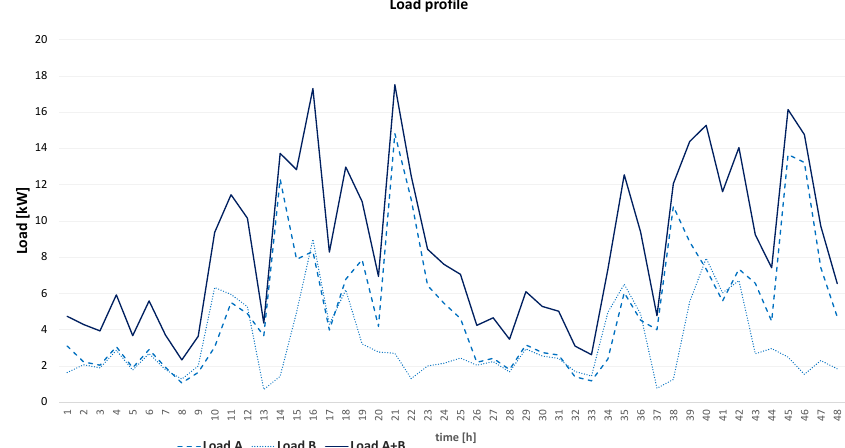
Figure A5. Data Input Load A and B for Section